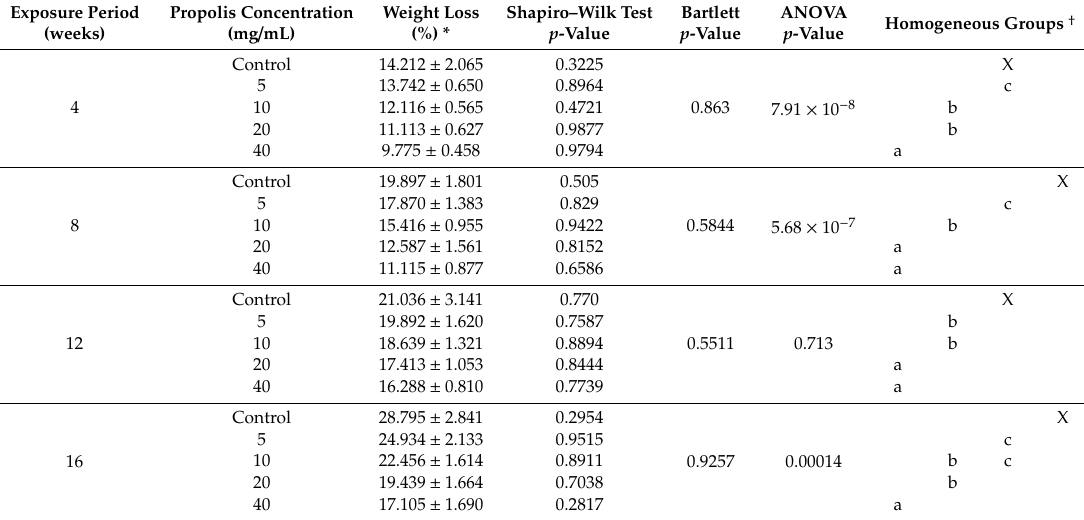
Table 4. E ff ect of treatment concentration of propolis ethanolic extract and time of fungus exposure (sampling) on the protection of poplar wood against T. versicolor .